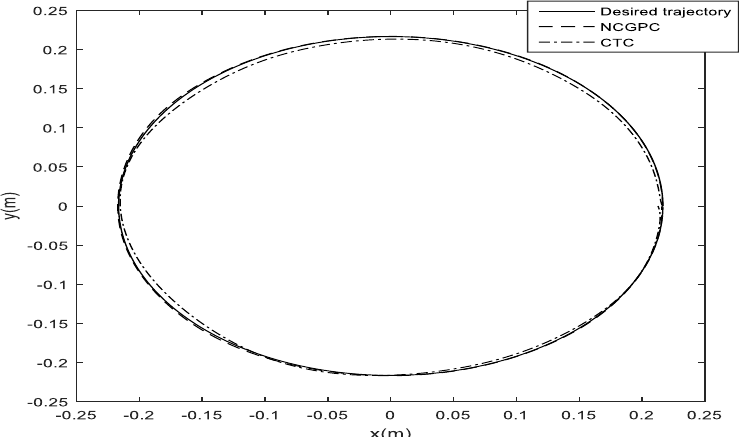
Figure 12. Desired and actual trajectories in task space.